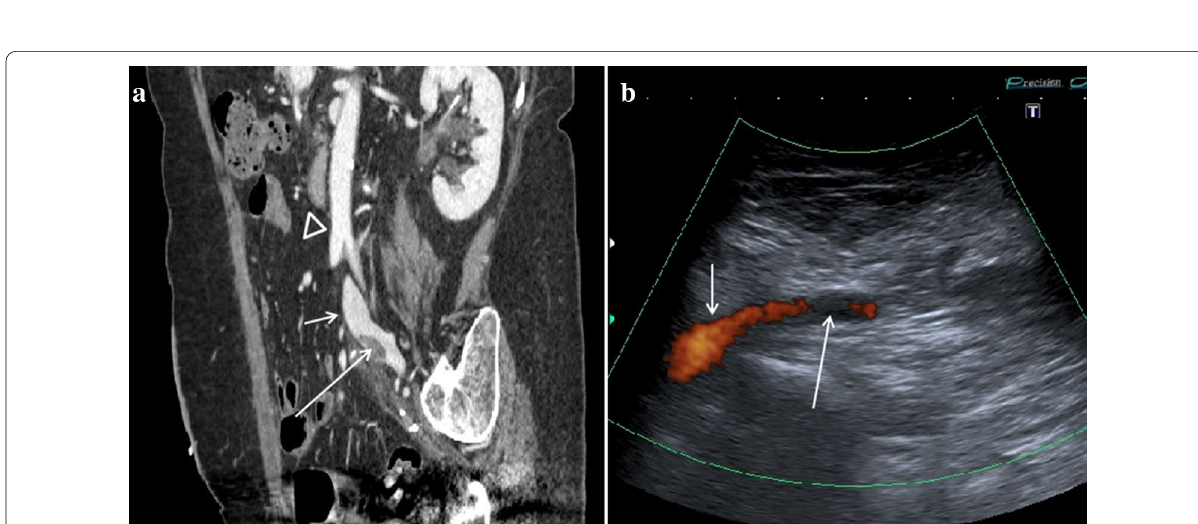
Fig. 14 Abdominal MDCT examination. a The sagittal plane reconstruction shows an enhancement defect (long arrow) in the left common iliac vein (short arrow) due to a thrombus. Abdominal aorta (head arrow). b Power Doppler US shows a thrombus (long arrow) in the left common iliac vein (short